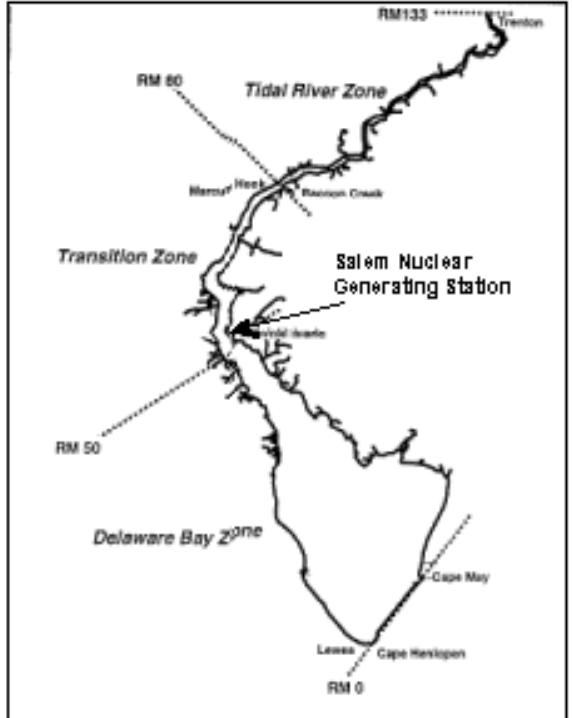
FIGURE 1. Longitudinal zones of the Delaware